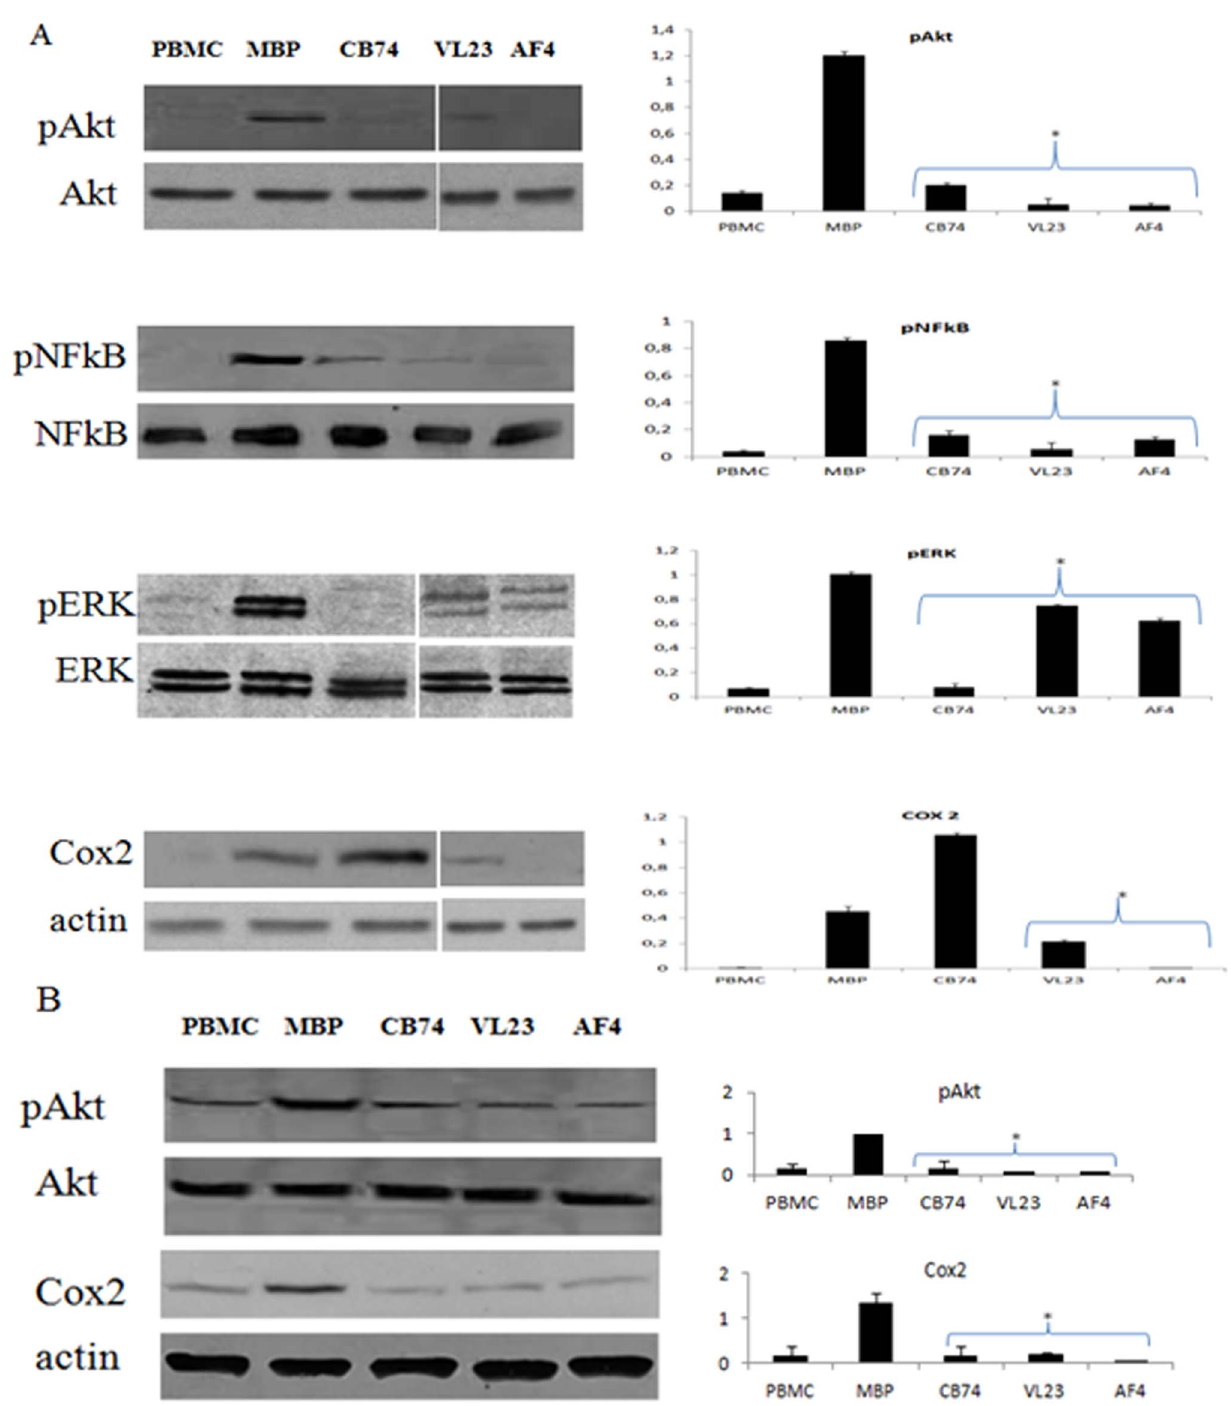
Figure 5. 1,8-naphthyridine, pyridine and quinoline derivatives control Akt, NF-kB, Erk and Cox-2 expression. MBP activated PBMC were treated with the compounds at the concentration of 10 m M and cultured for 6 days. After the incubation, cell extracts were prepared and protein expression was determined by western blot analysis. In the blots, the bands of un-stimulated cells (PBMC in the figure), MBP activated cells (MBP in the figure) and the treatment with CB74, VL23 and AF4 are showed. The expression of phosphorylated Akt (pAkt) normalized on total Akt (Akt) and Cox-2 normalized on actin is showed in control cells (A) and in patient derived cells (B). The densitometric analysis is also reported in the histograms for both MS patient and control derived cells. In addition, in control cells (A), the protein expression of pNF-kB 65 kDa normalized on total NF-kB 65 kDa and pErk normalized on total Erk is also showed along with their relative densitometric analysis. The blots are representative of four independent experiments and the densitometric analysis reports the mean of the values of all the experiments 6 the standard deviation (*p , 0,01 significant inhibition calculated with respect to MBP activate PBMC).